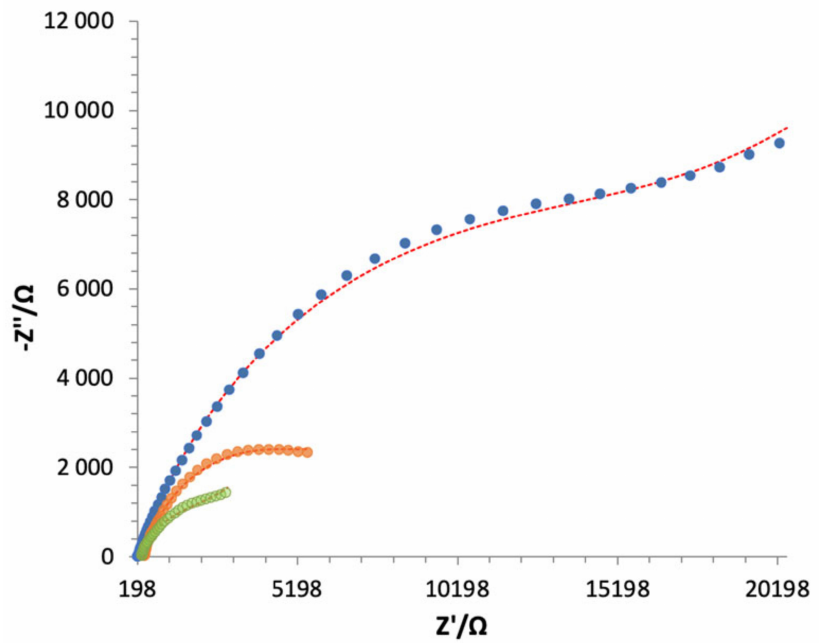
Figure 3. Nyquist plots of the NIP-modified electrode (blue bullets) and MIP-modified electrode after the template removal (empty green bullets) and after contact with IRB solution (empty orange bullets). Electrochemical probe: 5 mM K 4 Fe(CN) 6 /0.1 M KCl solution at pH 7.2.